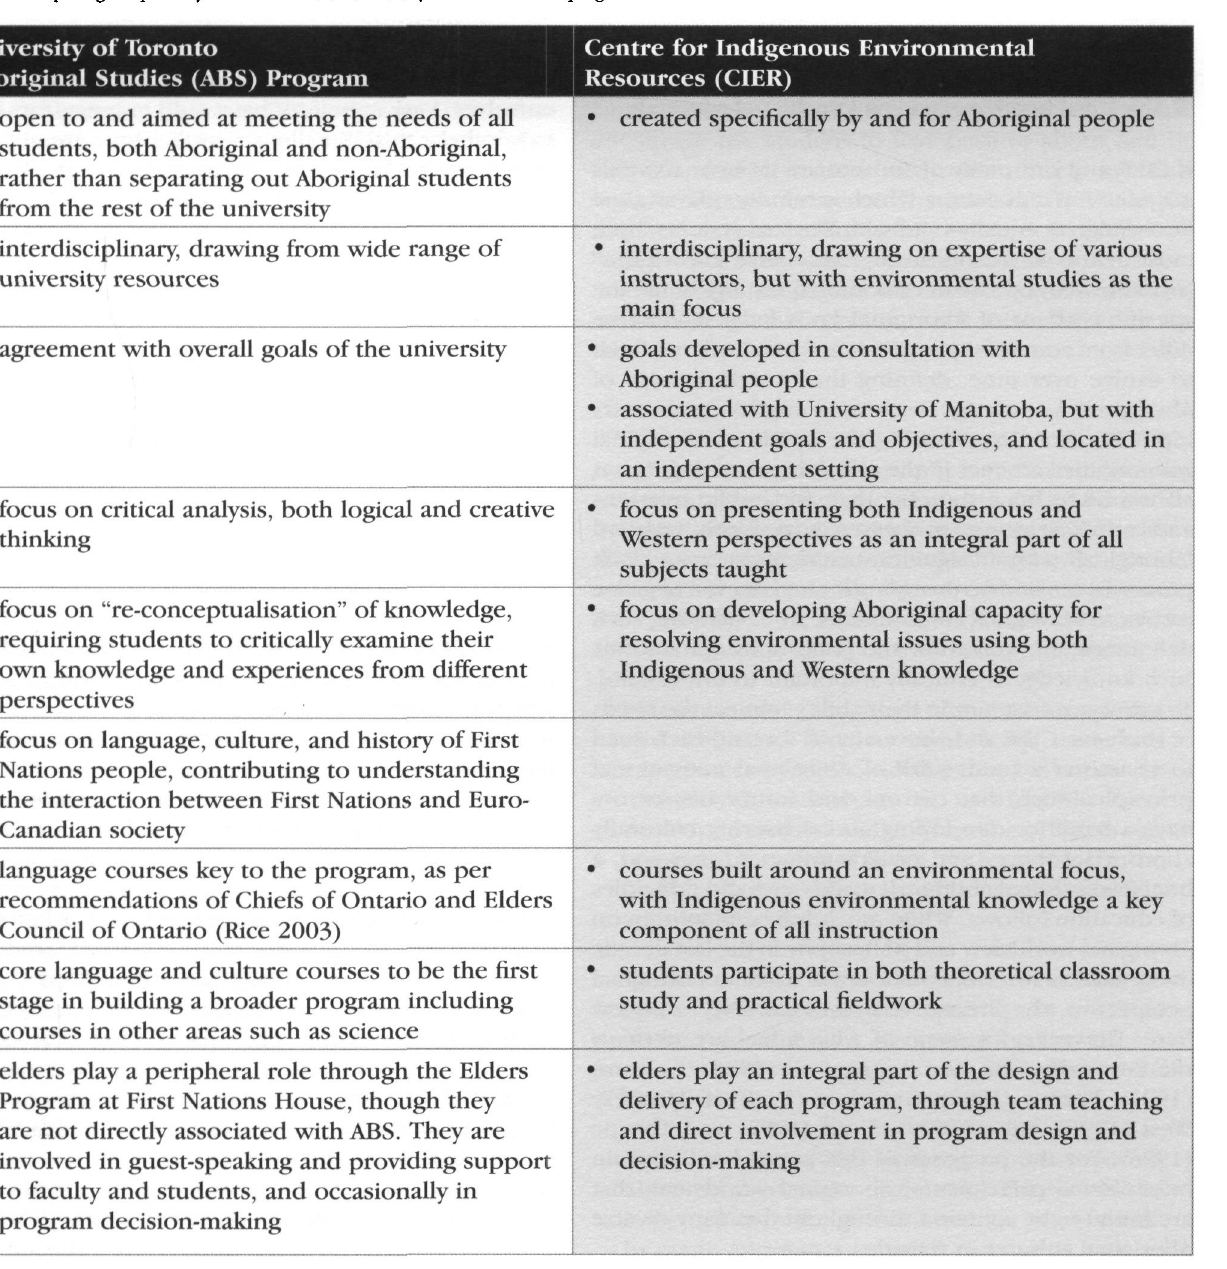
Table 1. Comparing the primary characteristics of University of Toronto's ABS program with